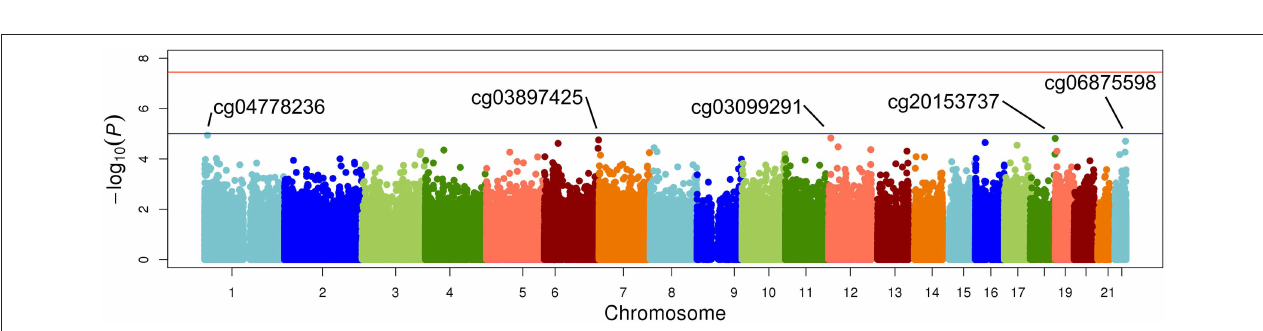
FIGURE 2 | Epigenome-wide Manhattan plot for change in DNA methylation by change in HDL after 3 weeks of daily fenofibrate (160mg).